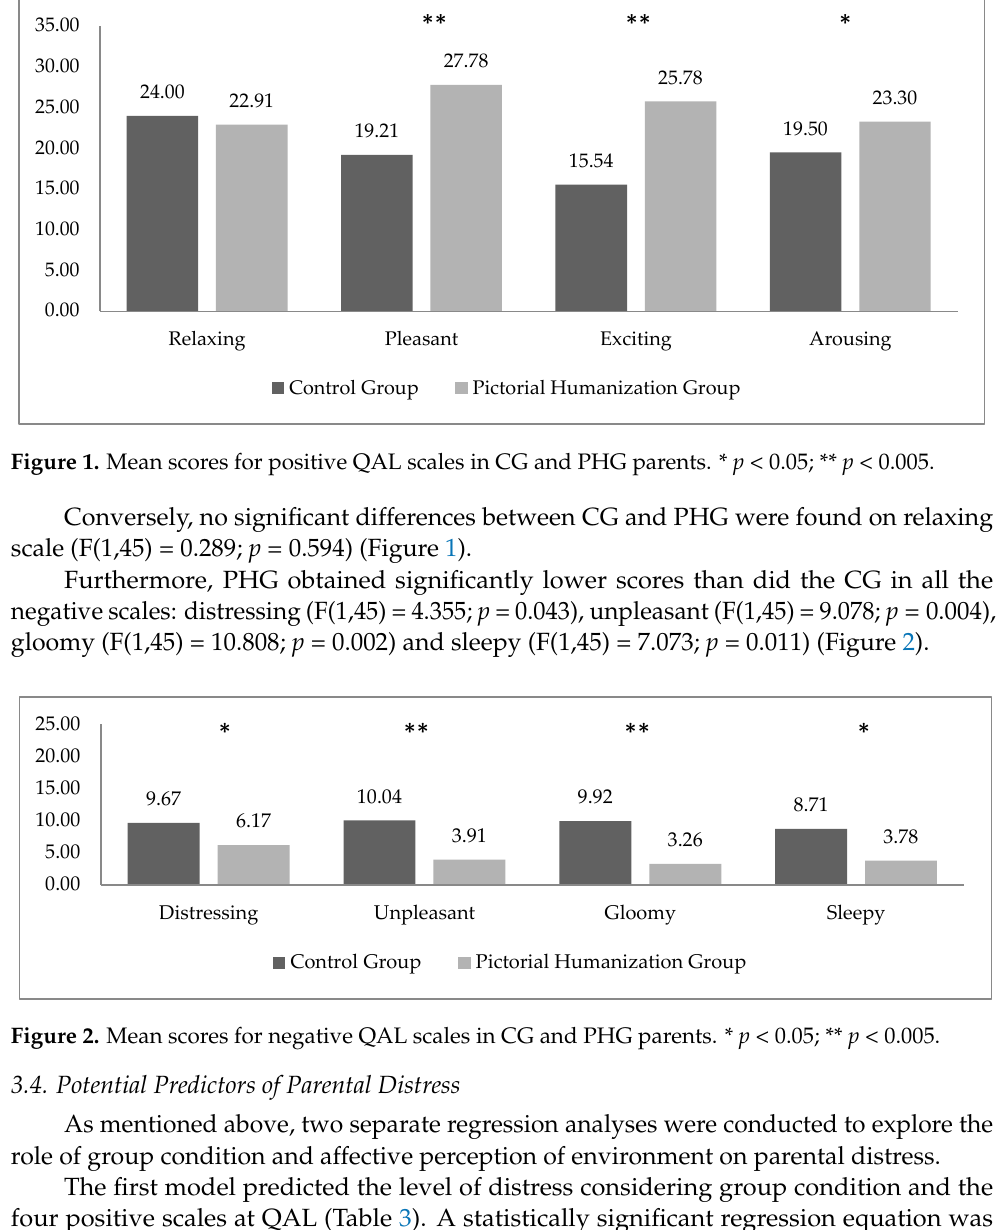
Figure 2. Mean scores for negative QAL scales in CG and PHG parents. * p < 0.05; ** p < 0.005.